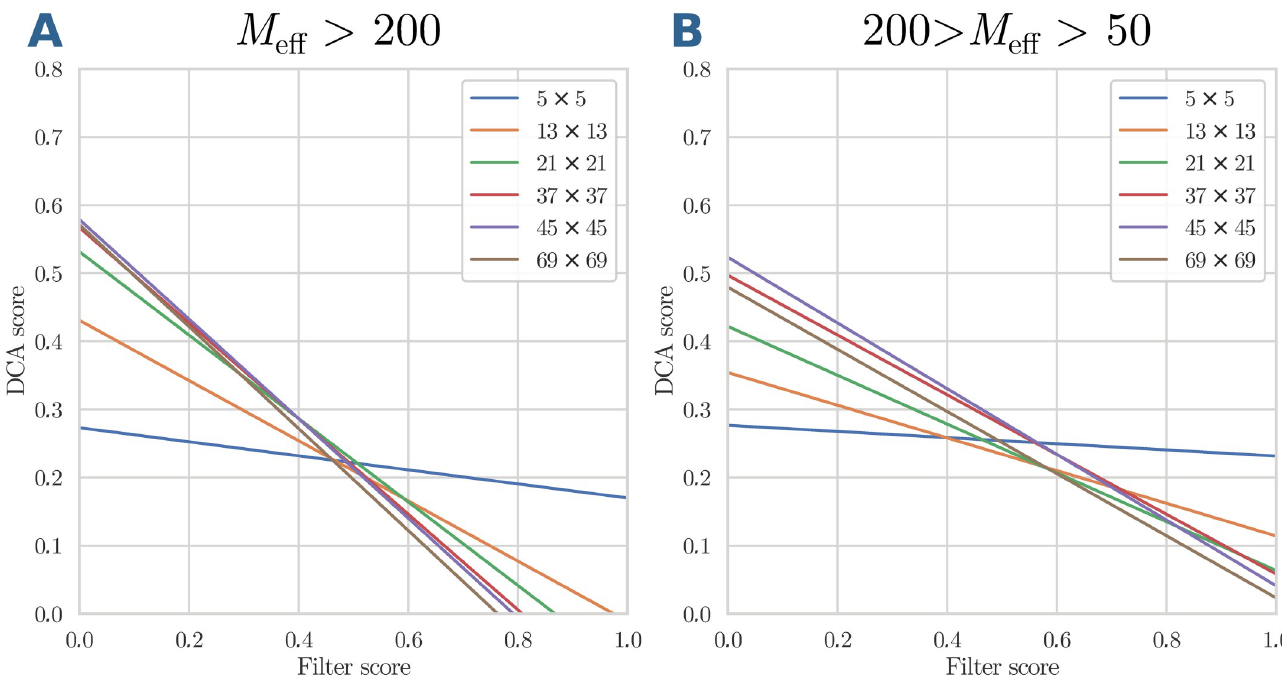
Fig 4. Decision boundary for logistic regression. The lines show, for large (panel A) and medium (panel B) MSA sizes, the decision boundary defined by P ( � | x ) = 1/2, for different filter sizes raging from 5 × 5 to 69 × 69.